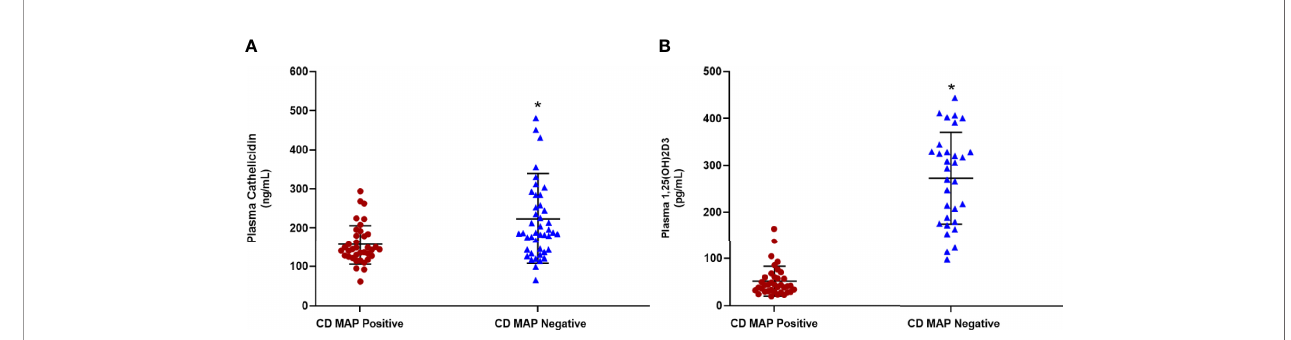
FIGURE 1 | Levels of cathelicidin (A) and calcitriol (1,25(OH)2D3) (B) in clinical plasma samples obtained from MAP-positive CD and MAP-negative CD patients (N= 40 per group), were determined by the Human Cathelicidin Antimicrobial Peptide ELISA Kit (MyBioSource, San Diego, CA) and the Calcitriol ELISA Kit (MyBioSource, San Diego, CA). *Indicates P-value of less than 0.05.